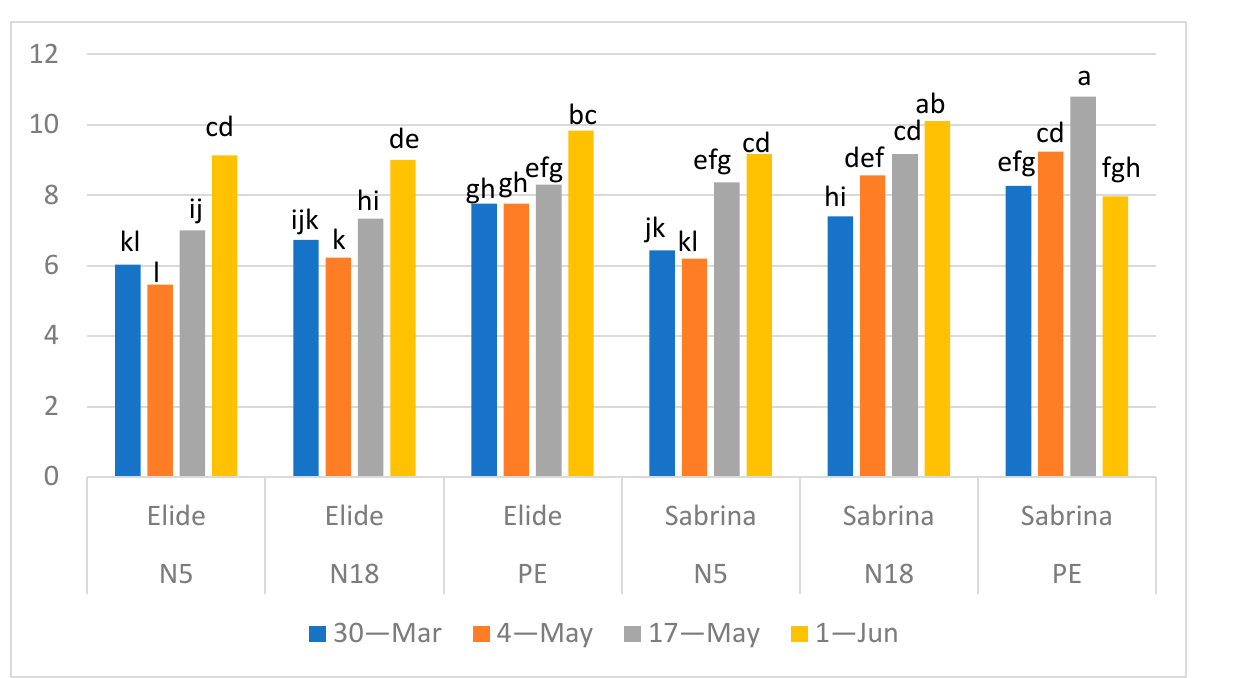
Figure 2. Effect of Mulch × Cultivar × Time of sampling interaction ( p < 0.0001) in total soluble solid content (° Brix). Means followed by the same letter do not differ significantly at p = 0.05 (Tukey HSD test).